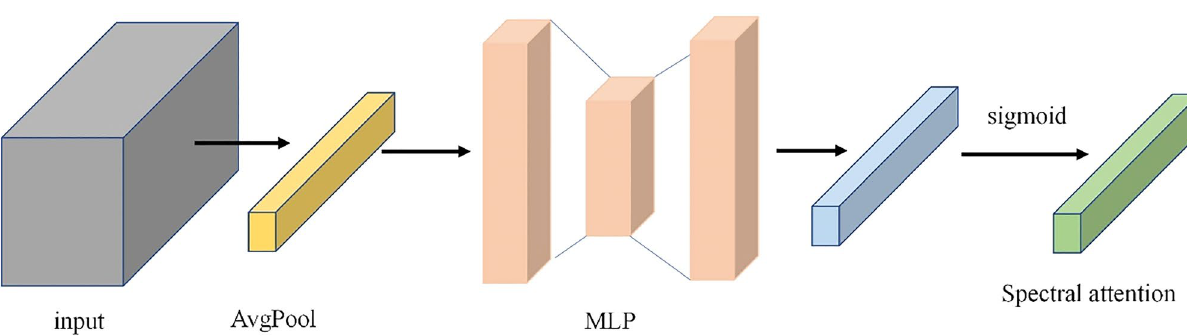
Figure 3. The structure of the attention module. The input of this model is the neighborhood pixel patch of the original hyperspectral image, and the output is the feature map.